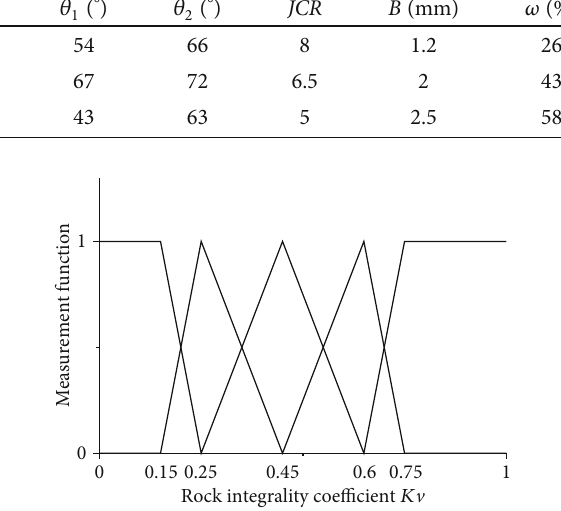
Figure 2: Uncertainty measurement function of Rc.